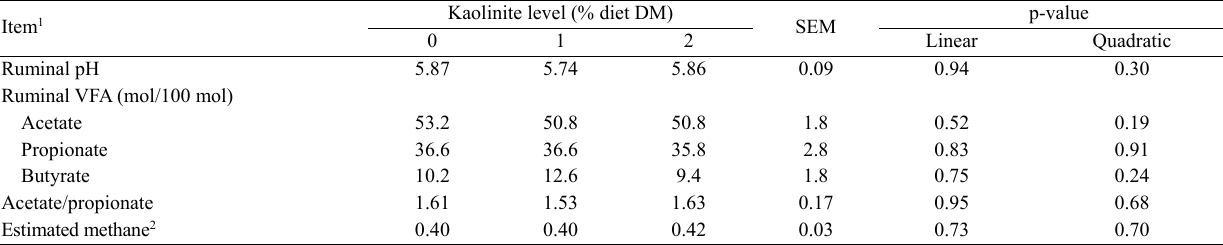
Table 3. Influence of supplementation level of kaolinite clay on ruminal pH, volatile fatty acid profile and estimate methane production